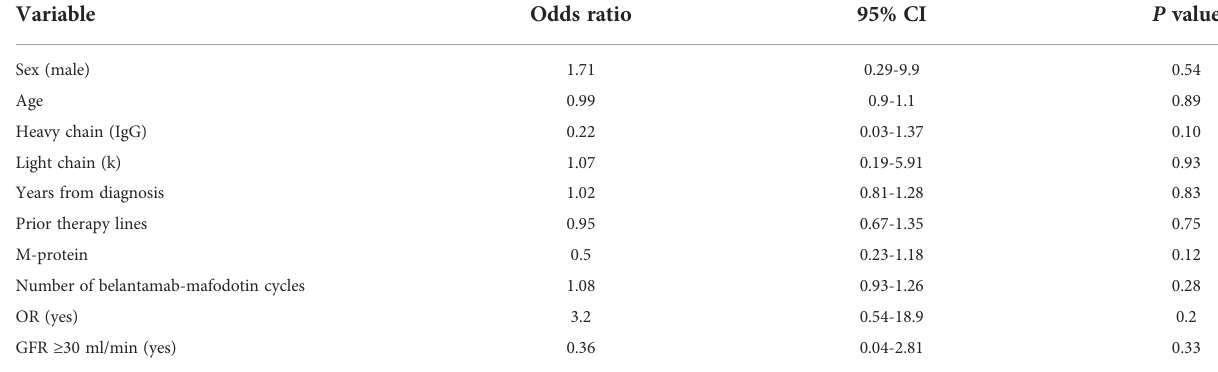
TABLE 4 Univariate analysis — keratopathy (N =